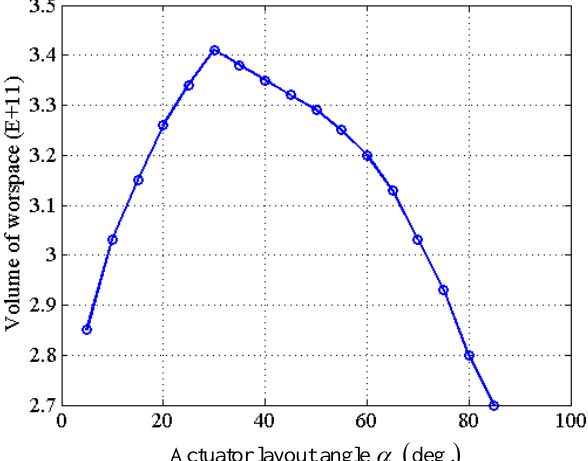
  Actuator layout angle deg. 